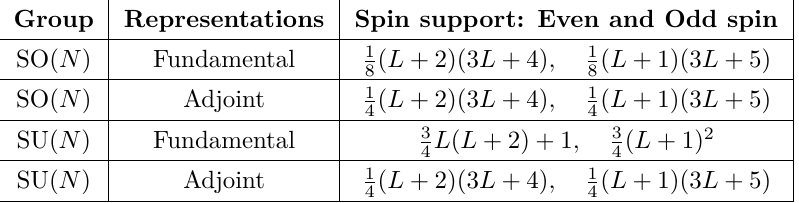
Table 1 . Spin support for bulk contact terms: scalars with global symmetry